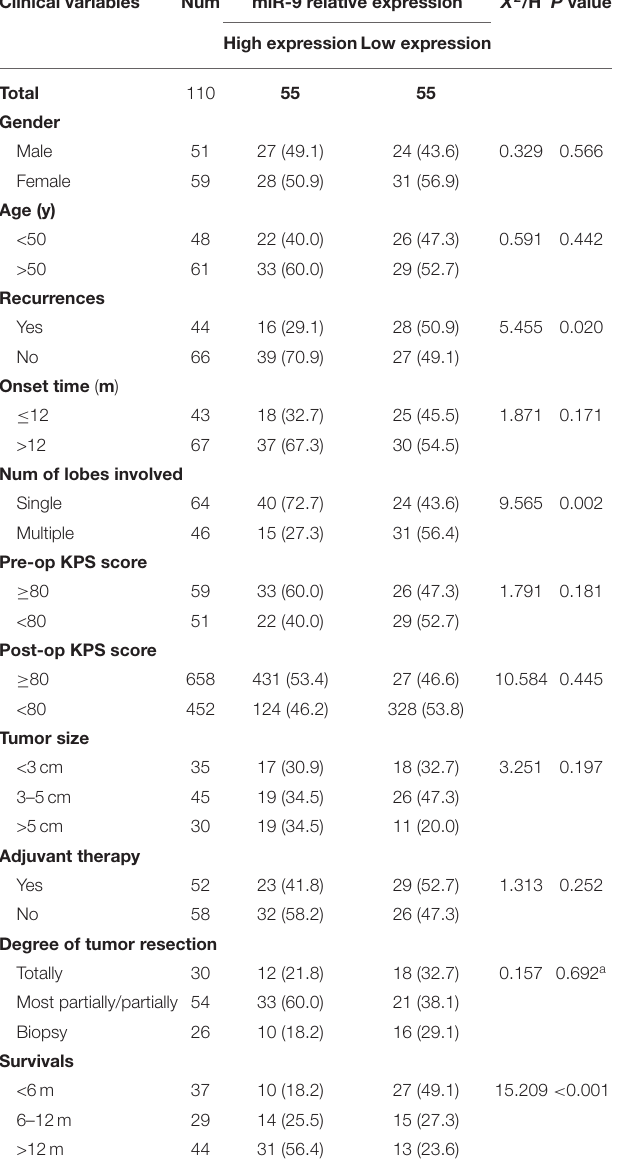
TABLE 1 | Clinical features and relative expression of miR-9 in glioblastoma (110 cases).